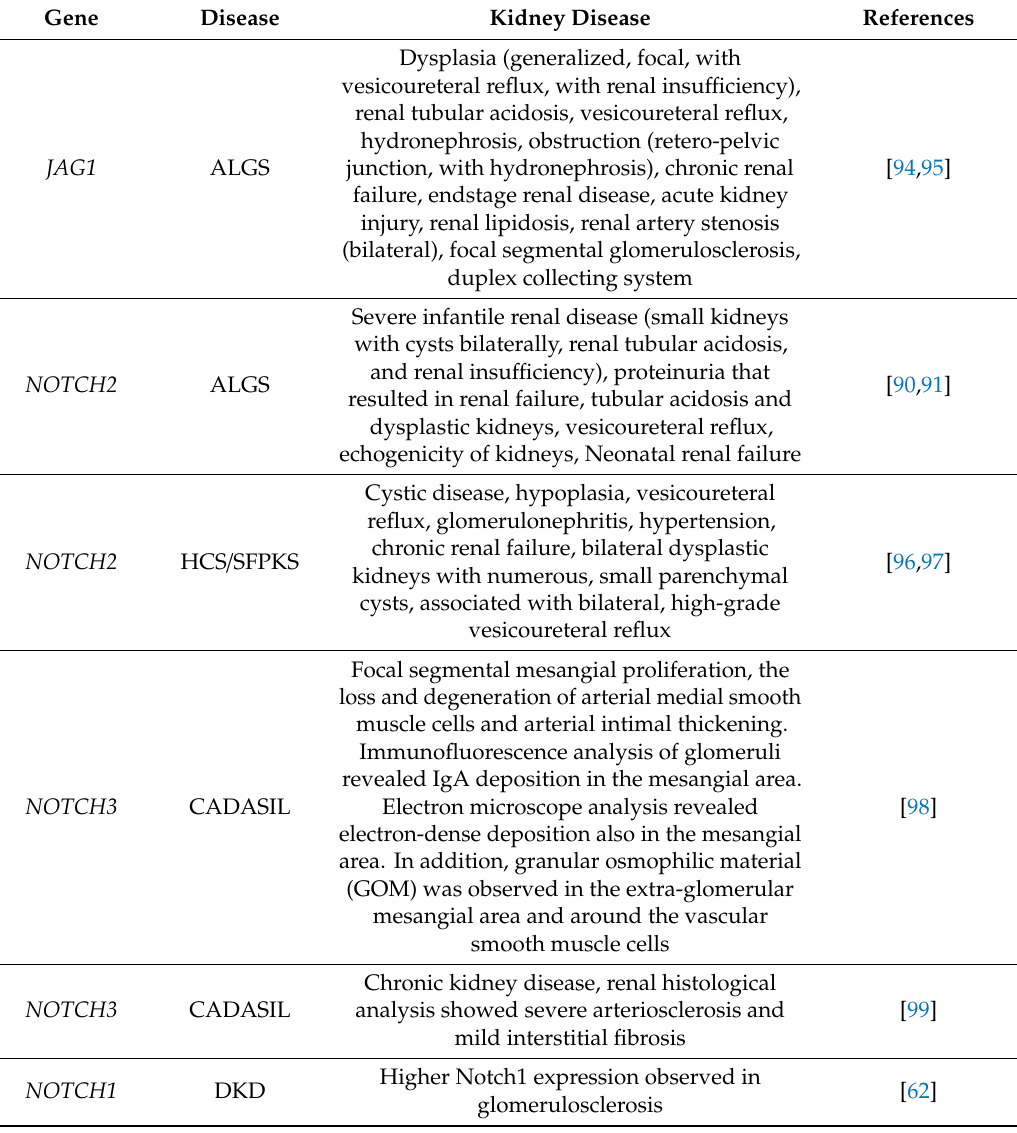
Table 3. Kidney diseases associated with alterations in Notch receptors and